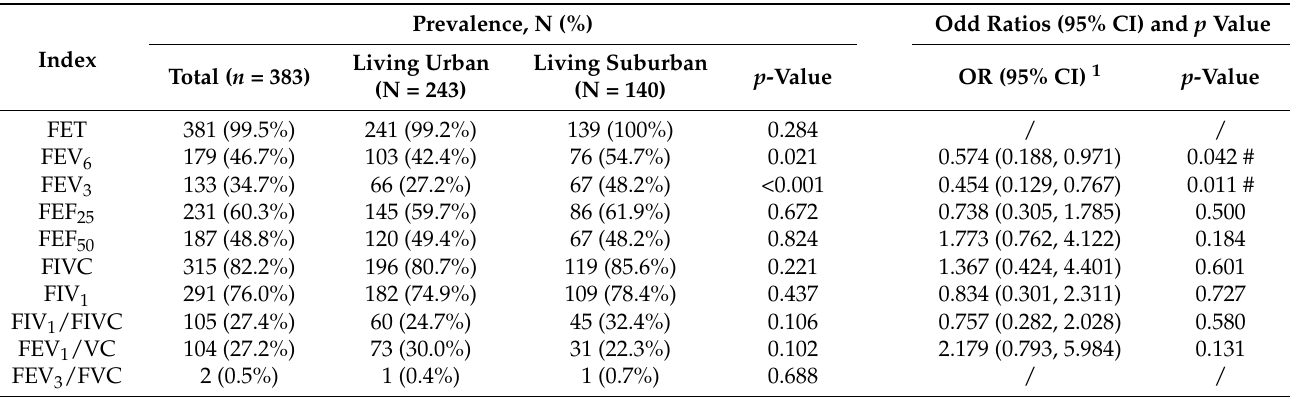
Table 3. Prevalence of lung function impairment in children with different areas, and the odds ratios (OR) and 95% confidence interval (95% CI) of the prevalence of lung function impairment in children in urban areas versus rural